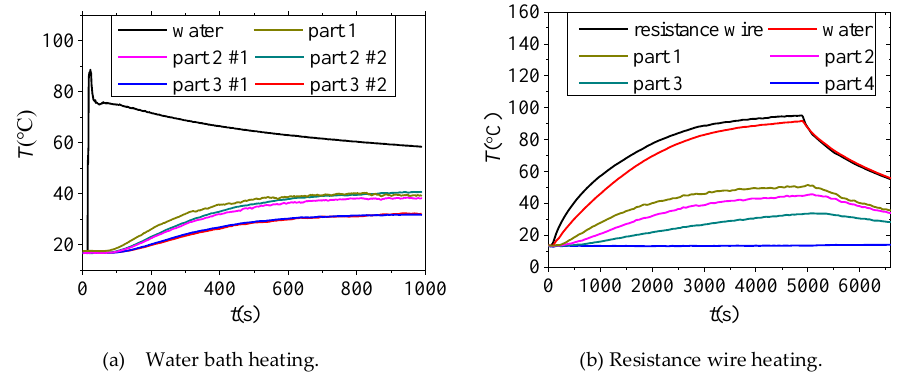
Figure 12. The temperature changes while heating the insulated sheath in PICJB.